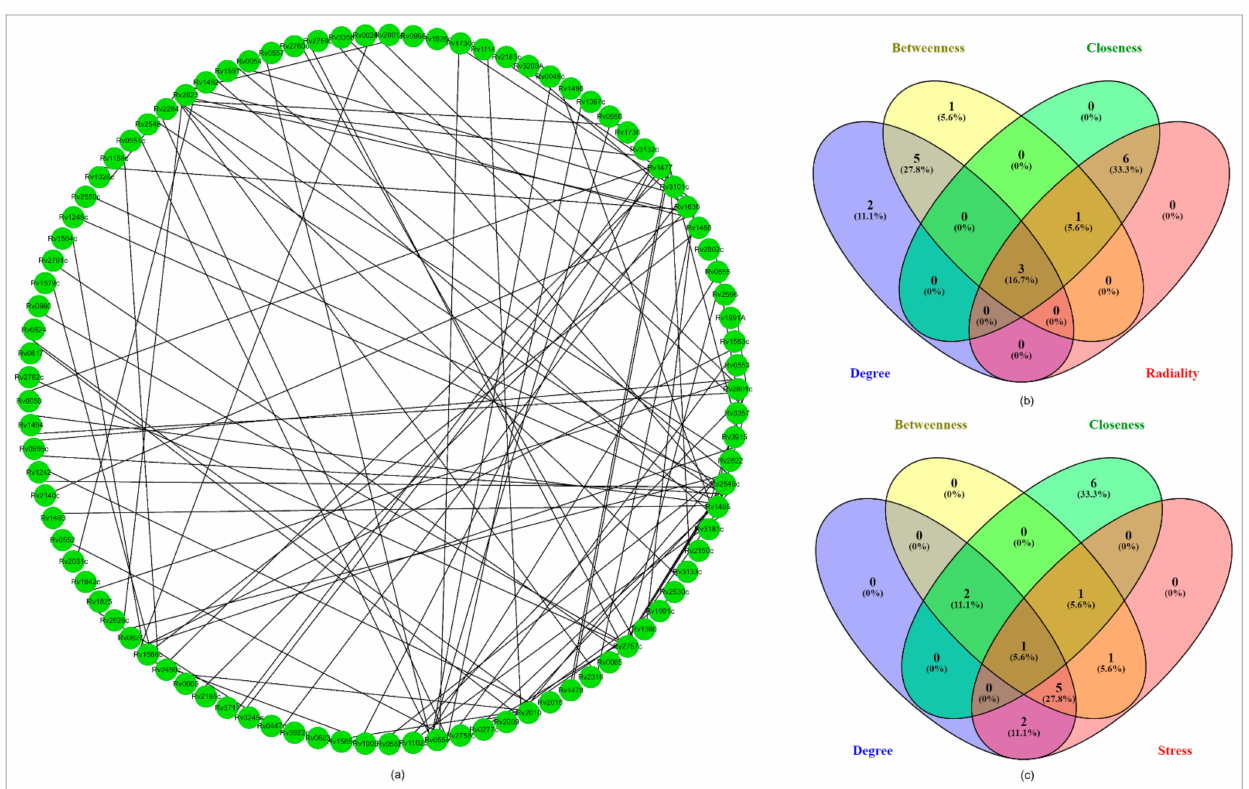
Figure 6. Network analysis: ( a ) PPI network of the selected ten virulent genes which were involved in significant pathways comprised a total number of 93 nodes and 101 edges. ( b ) Venn plot showing the intersection of degree-based radiality category found 3 genes. ( c ) Venn plot showing the intersection degree-based stress category found 3